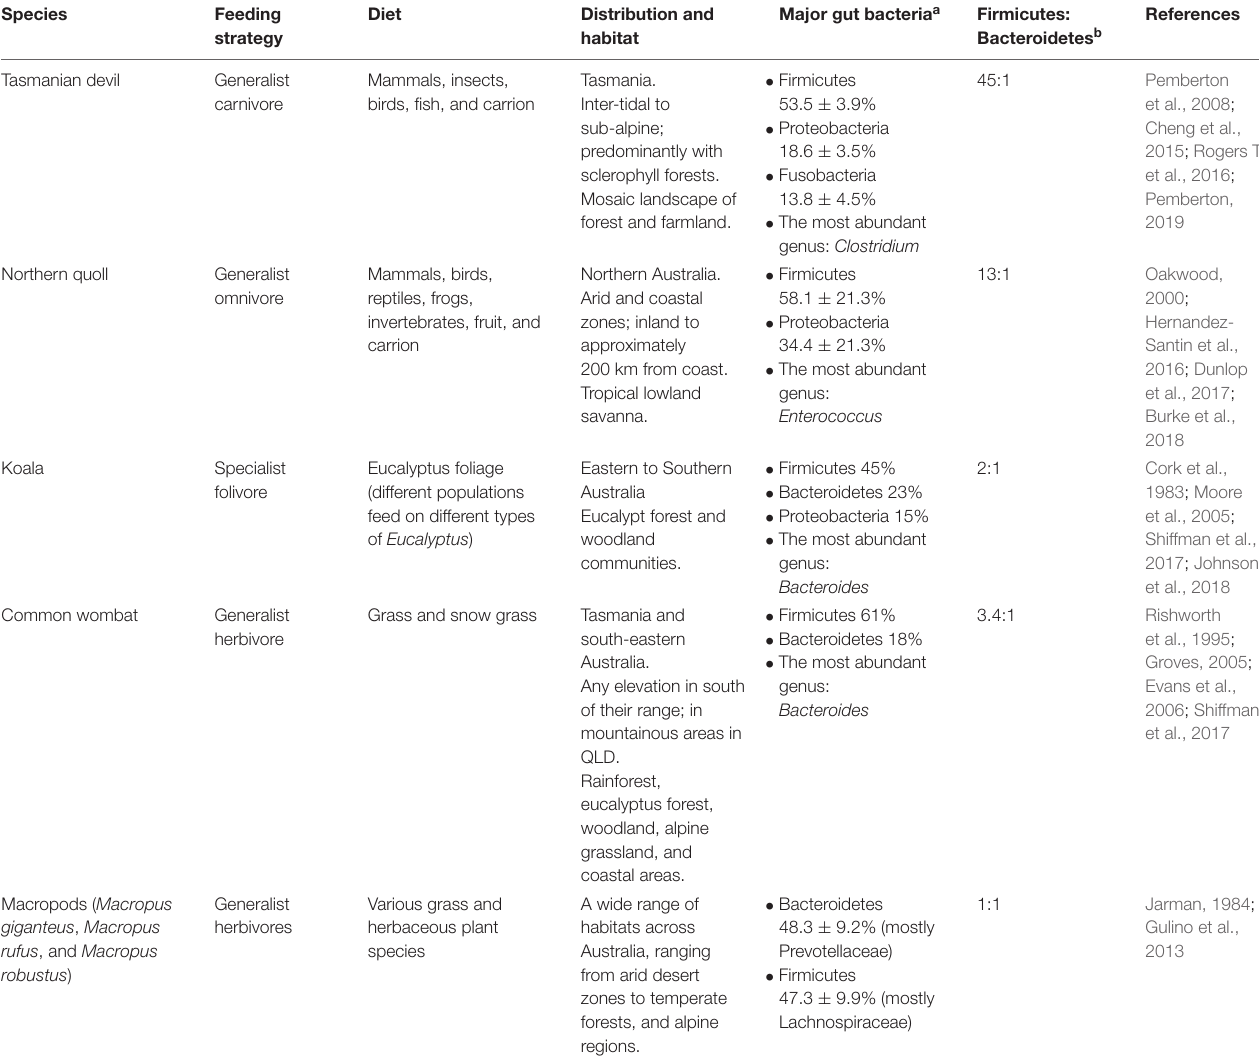
TABLE 1 | Comparison of diet, habitat, and gut microbiome in